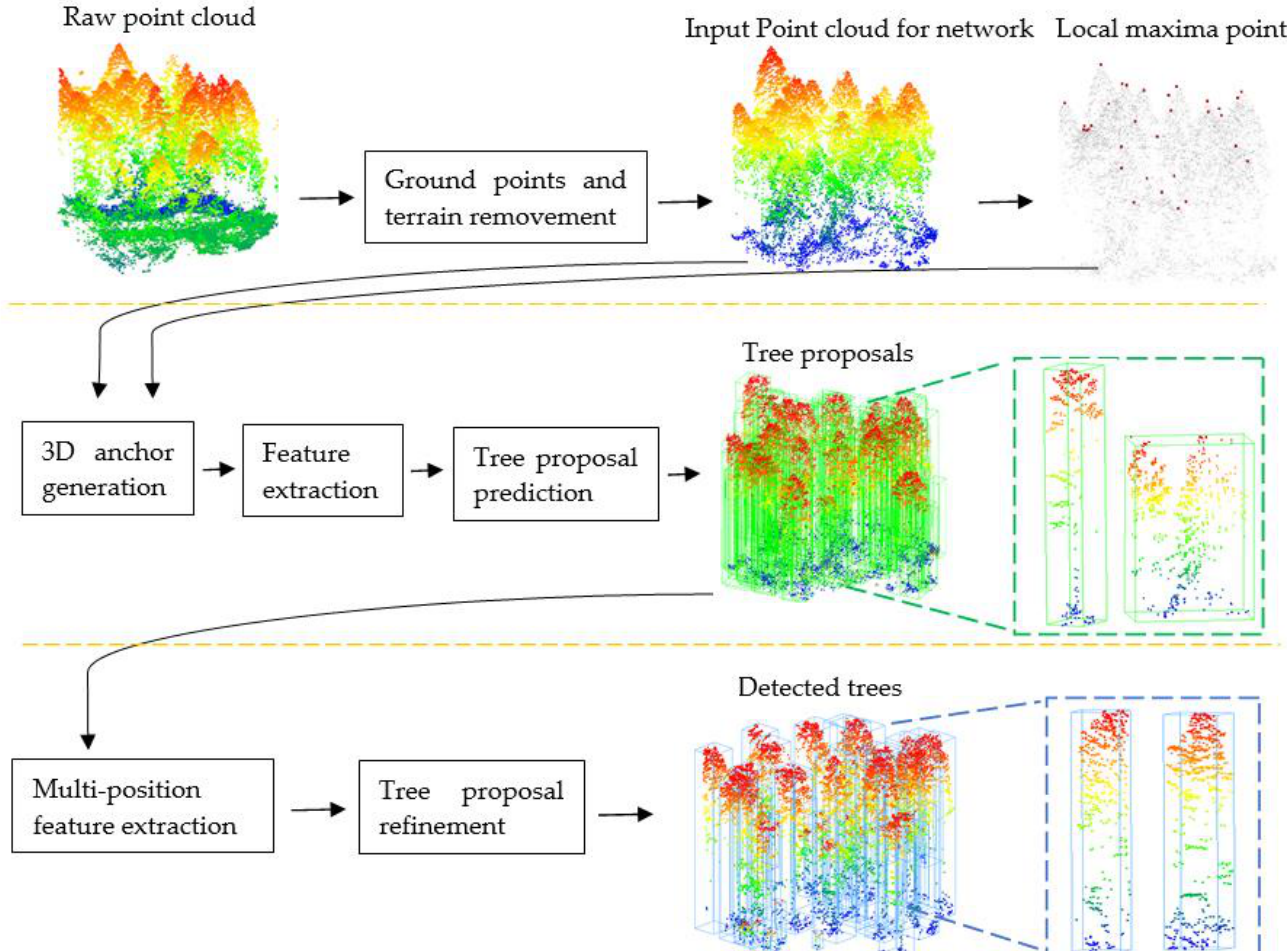
Figure 1. The Tree RCNN architecture for tree detection. The first line is the preprocessing. The second line is the 3D proposal generation stage. The third line is the tree proposal refinement stage. The green boxes are 3D tree proposals. The blue boxes are the final tree proposals.